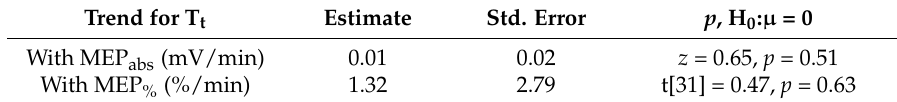
Table 2. The linear trends between T t and MEP abs and MEP % estimated by the statistical models. Trend for T